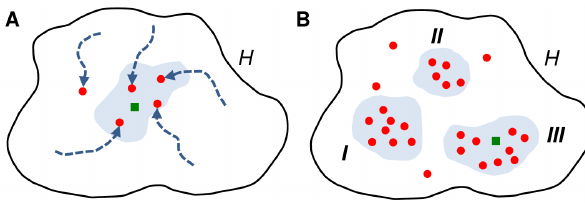
Figure 1. Reasons for ensemble averaging and its drawback. A) The hypotheses space H (black shape) contains all networks that can be represented by the applied mathematical framework. There might be no single optimum, as several different network structures might score equally well and thus are equally valid (blue area). Additionally, optimization procedures starting from different initial parameterization might get stuck at local optima and create suboptimal predictions (red dots). If the applied framework is adequate, the reference structure is included in H (green square) and could be predicted by the optimization procedure. Otherwise, predicted high scoring networks should be at least similar to the reference. Here, all high scoring predicted networks are very similar to each other and to the reference.